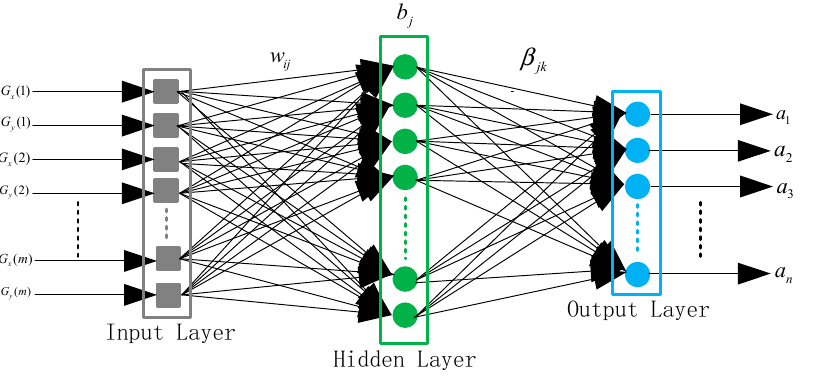
Figure 3. The network structure of the ELM